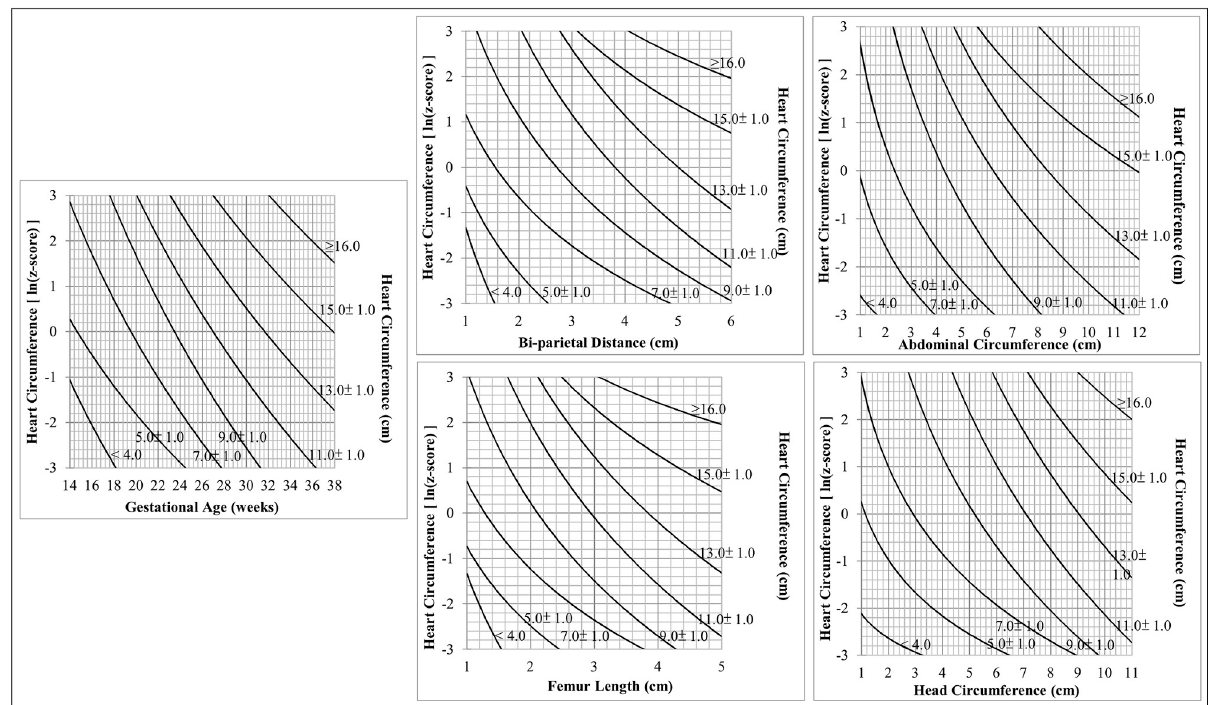
Fig 3. Nomogram for heart circumference by estimated gestational age, bi-parietal distance, femur length, abdominal circumference, head circumference.